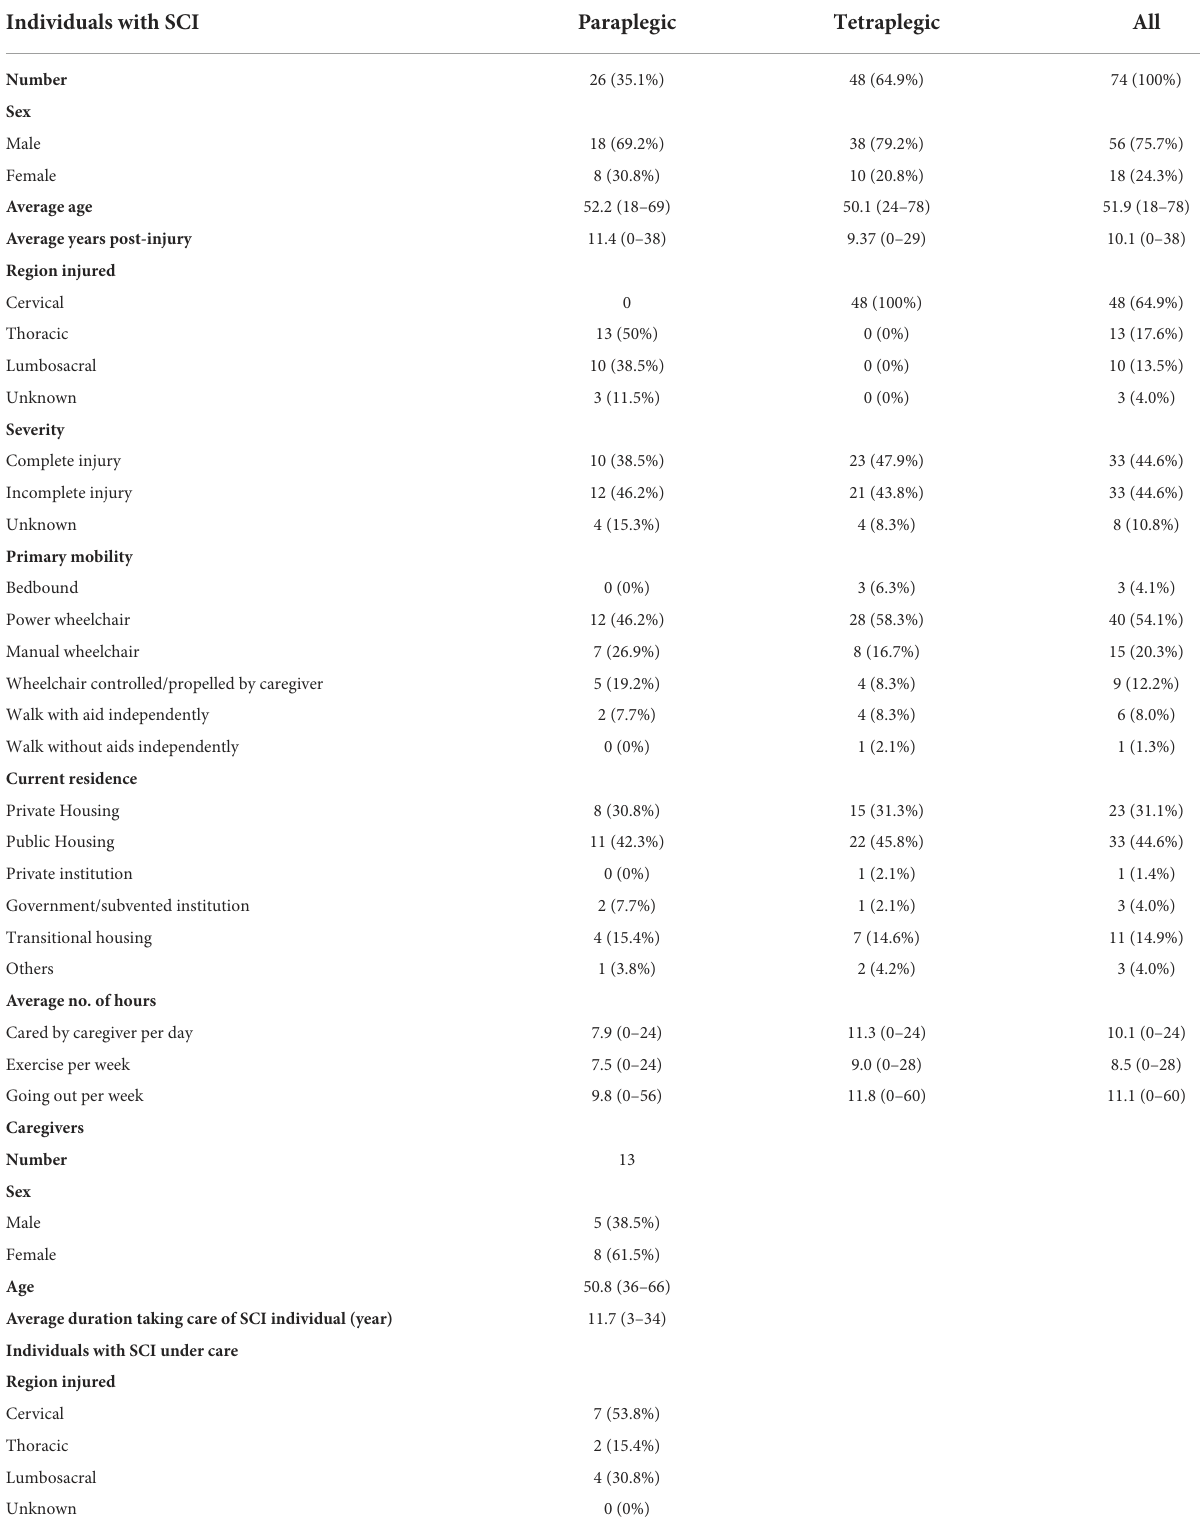
TABLE 1 Characteristics of survey participants.